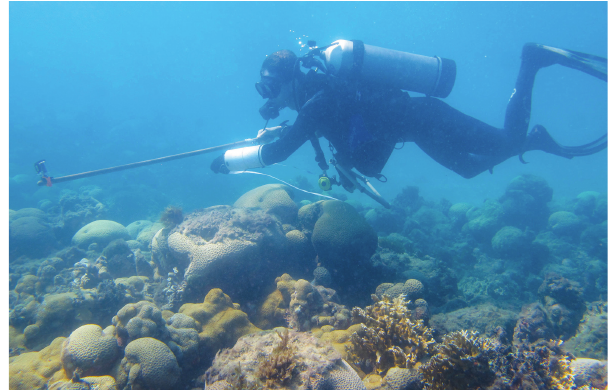
Fig. 2. Scuba diver using a wooden handle to simulate the spearfisher behavior.